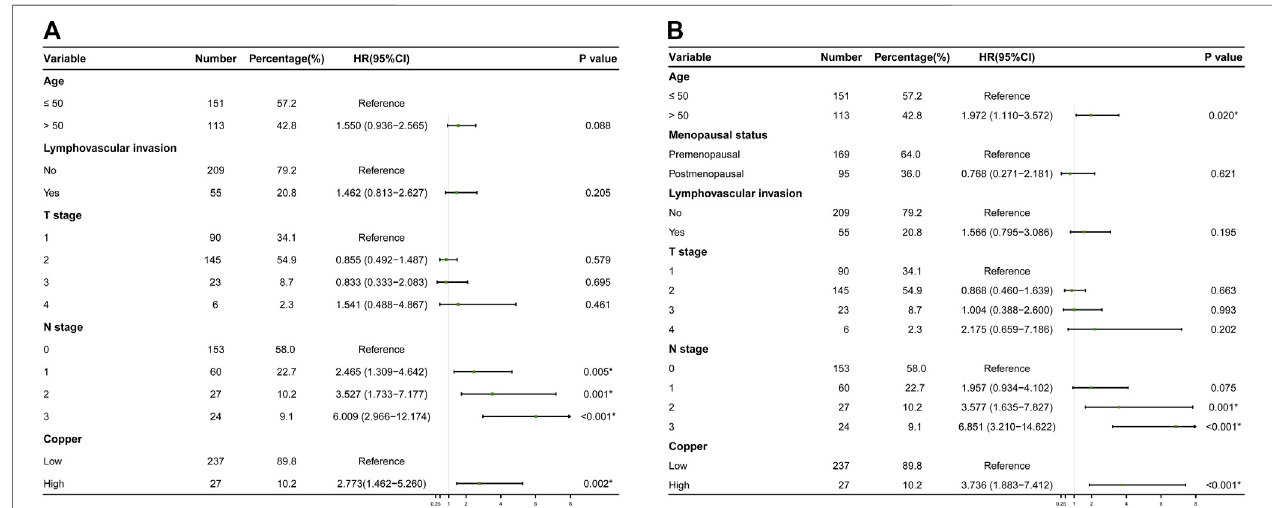
FIGURE 4 | Results of fi nal multivariate Cox regression analyses in the training cohort are represented as forest plots. (A) Forest plot of disease-free survival (DFS) probability. (B) Forest plot of overall survival (OS).